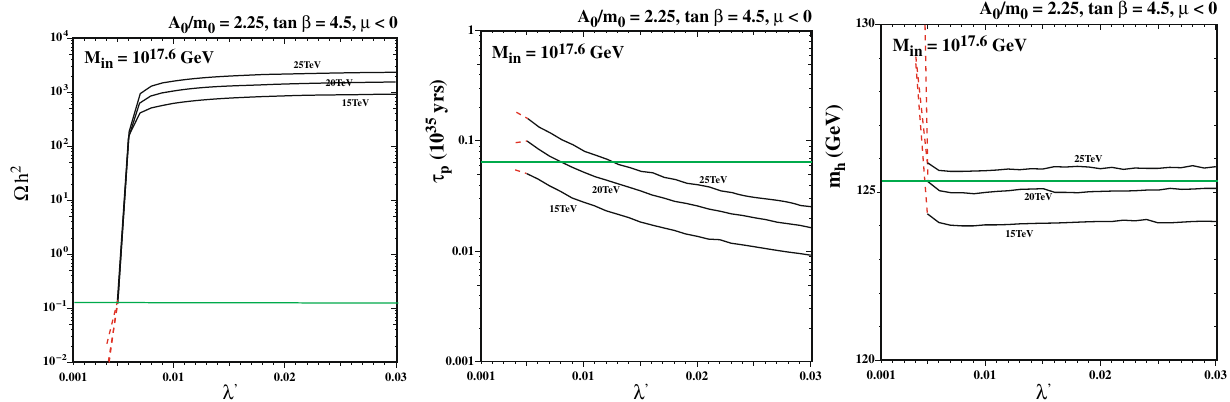
Fig. 12 As in Fig. 6, as functions of λ (cid:5) for the indicated fixed values of m 1 / 2 ∈ [ 15 , 25 ] TeV and m 0 chosen to obtain the cosmological value of (cid:21) 2 for λ (cid:5) = 0 . 005, with the same values of the other input parameters as in Fig. 3 LSP h